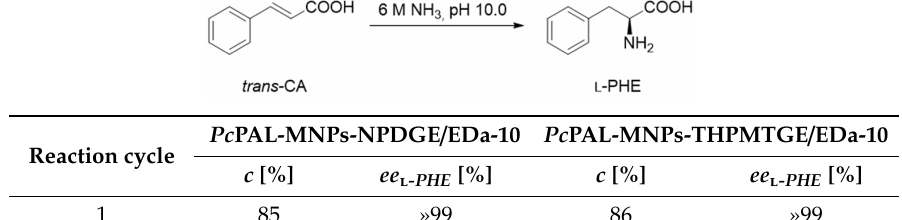
Table 5. Conversions and enantiomeric excess values of the operational stability tests of immobilized Pc PAL biocatalysts in the ammonia addition onto trans -cinnamic acid. All the measurements were performed in triplicate, and the standard deviations were below 5%. For experimental conditions see Supplementary Materials Section